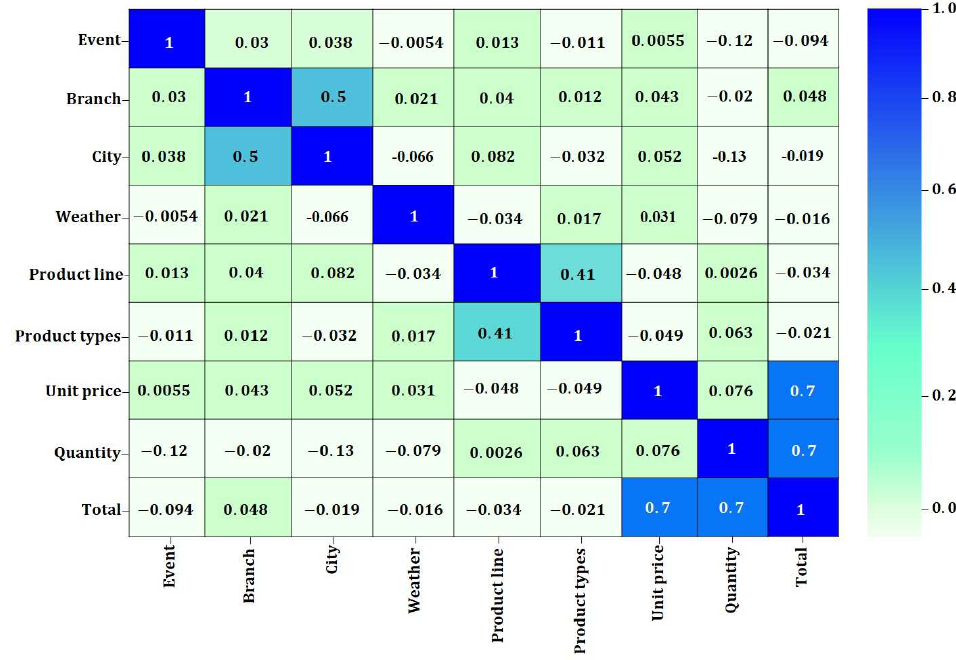
Figure 5. Coefficient matrix of designed features.